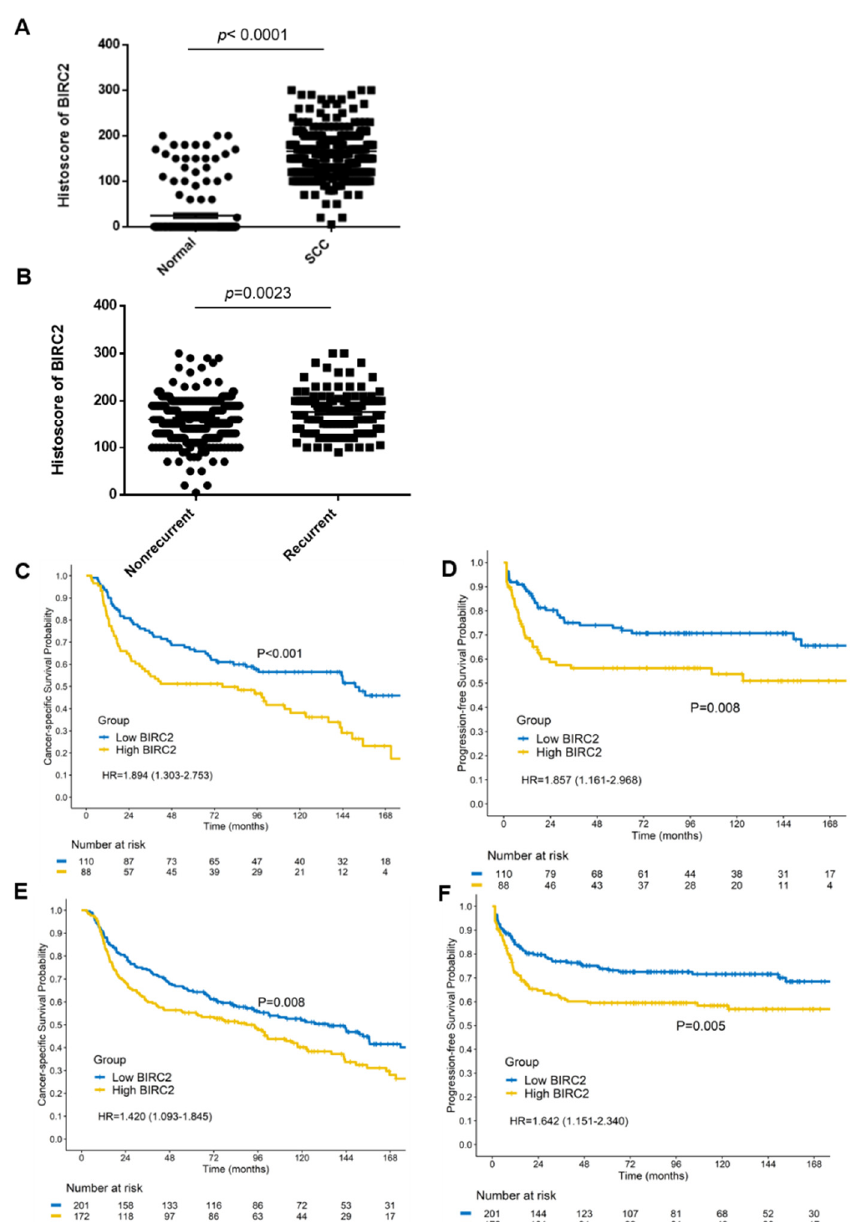
Figure 7. BIRC2 expression in α 7-HPV-related cervical SCC (including mixed infections). ( A ) Im- munohistochemical testing was conducted to analyze BIRC2 protein expression in formalin-fixed paraffin-embedded samples of biopsy tissue from patients with cervical SCC (n = 373) and adjacent normal tissues (n = 168). ( B ) Histoscores of cervical SCC were divided into recurrent (n = 124) and nonrecurrent tumors of cervical SCC (n = 249). ( C ) Kaplan–Meier survival curves indicate that for pa- of ≥ 175 was associated with worse CSS ( p < 0.001) and ( D ) PFS ( p = 0.008). ( E ) Kaplan–Meier